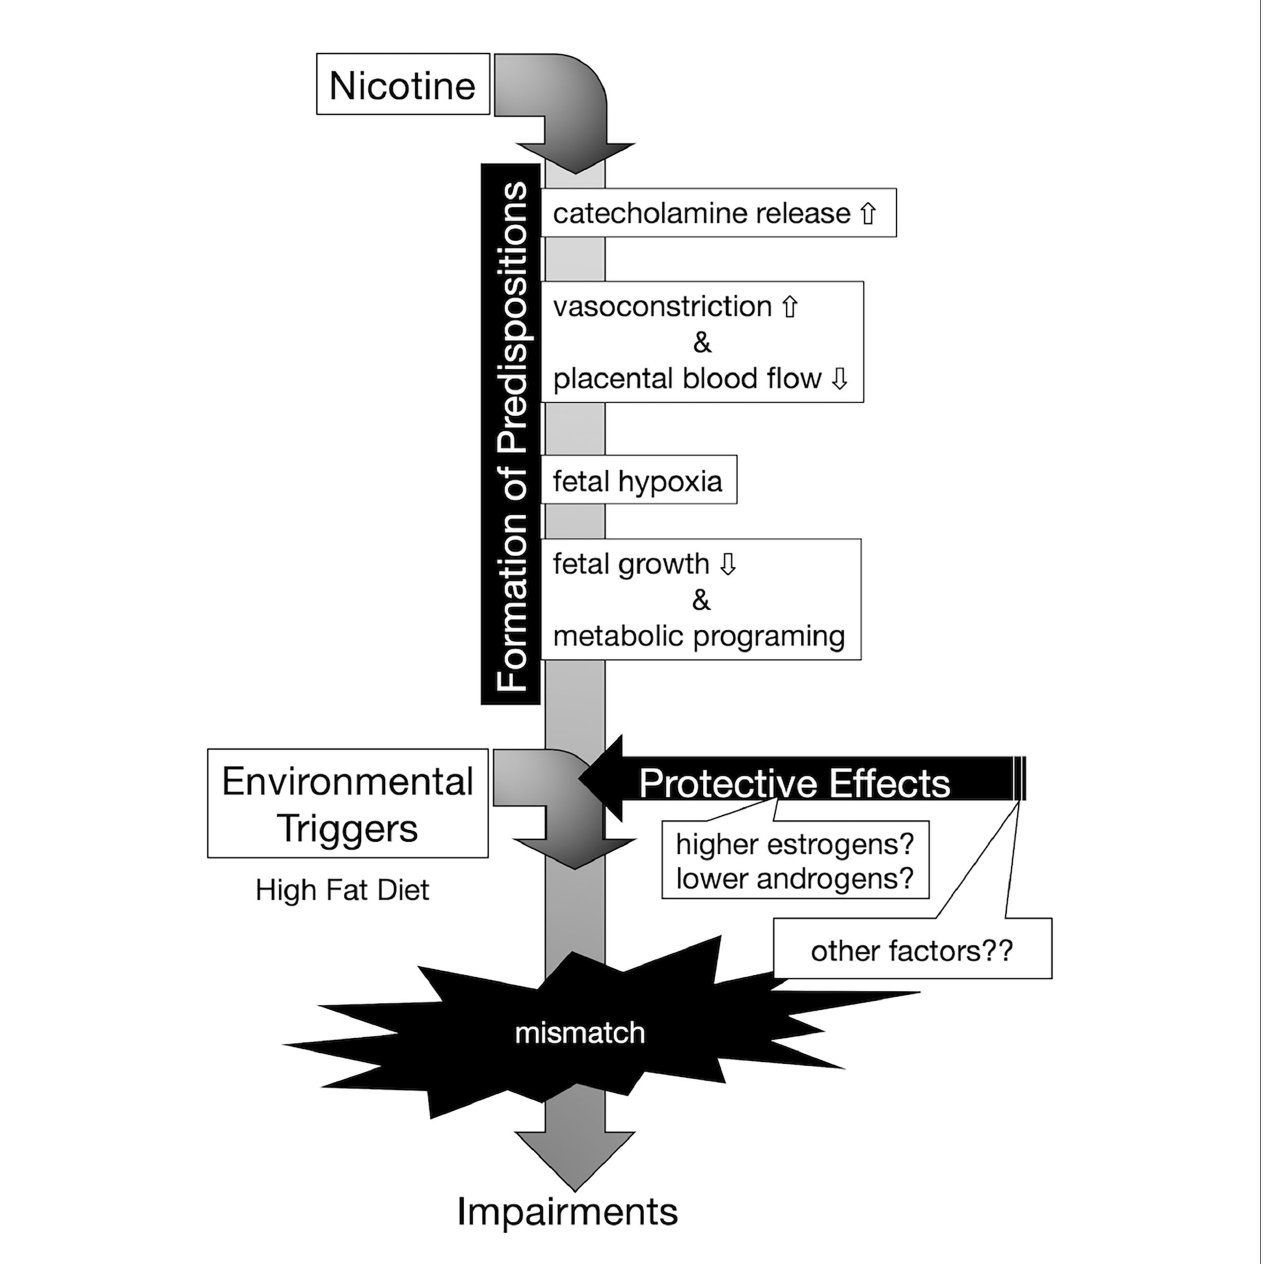
FIGURE 6 | Conceptual diagram of the onset of hyperinsulinemia due to embryonic nicotine exposure. Exposure to nicotine in dams causes a decrease in uterine blood fl ow, and metabolic programming due to hypoxia and malnutrition in the fetus is assumed. Nicotine may directly affect the egg via cord blood, but the effect is unknown in this study. According to DOHaD theory, the mismatch between the predispositions acquired by low-birthweight offspring and the post-growth environment increases the risk of developing the disease. Female hormones (estrogens) may act protectively in the development of diabetes. In our experimental model, it is possible that the decrease in the expression of insulin receptors in the liver was blocked in the female rats compared to that of male rats, but since there was no difference in the DNA methylation of the insulin receptor gene, further analyses are needed to clarify the mechanism underlying the sex-speci fi city in the